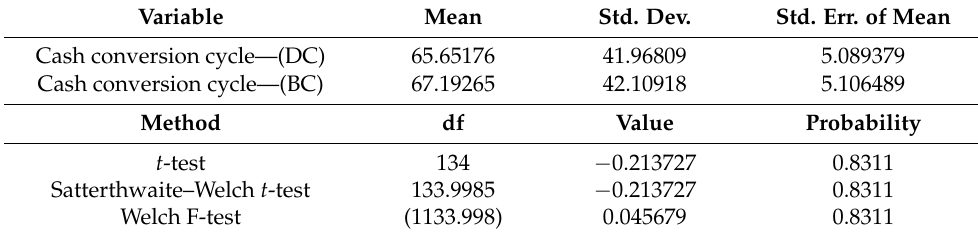
Table 10. The result of the cash conversion cycle (CCC).